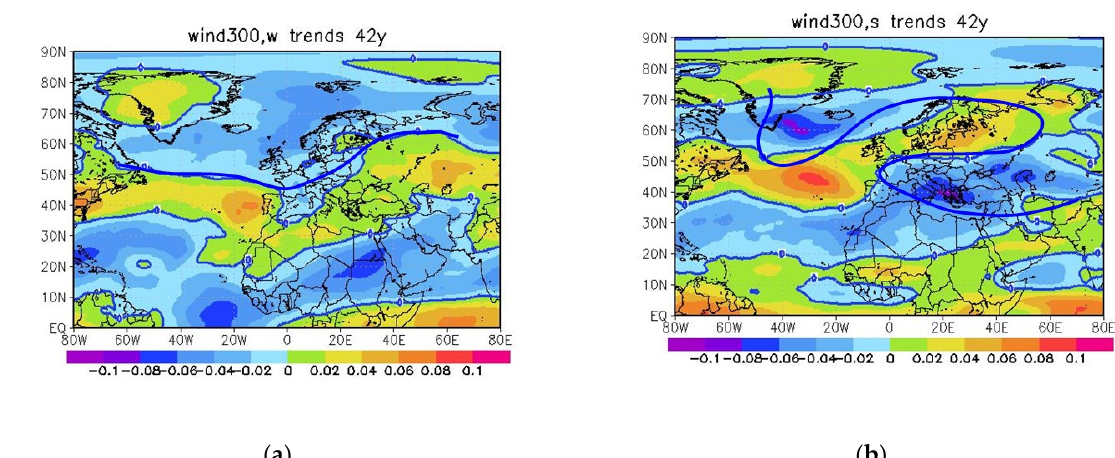
Figure 8. Wind magnitude at 300 hPa difference (P2–P1) (shade) for winter ( a ) and summer ( b ). The blue thick line is the smoothed zero line conceptualizing mean displacement from zonality in P2 relative to P1.